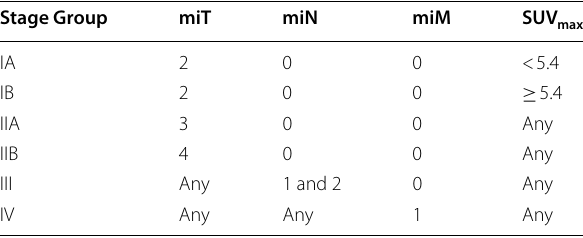
Table 2 Proposed miTNM stage groups for 68 Ga‑PSMA‑11